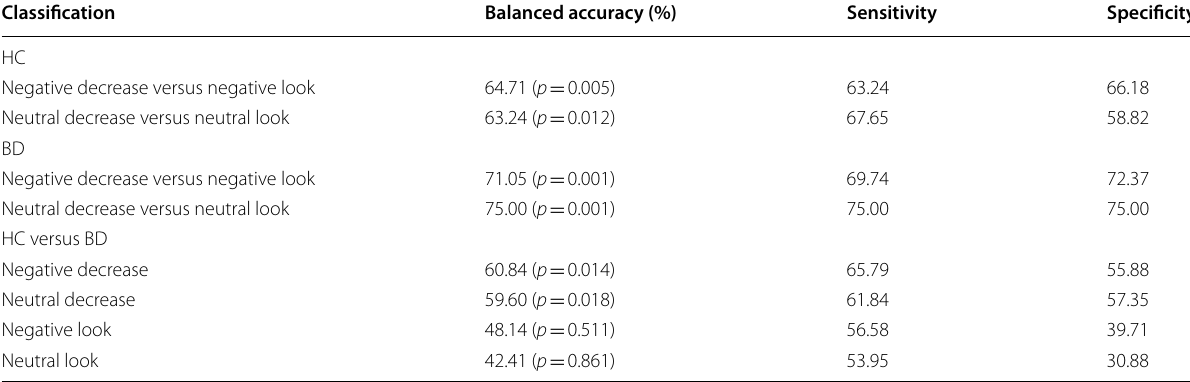
Abbreviations are as follows: HC healthy controls; BD bipolar disorder patients. Sensitivity refers to accurate classification of Decrease trials or BD subjects, whereas = = Specificity indicates the percent of accurately classified for Look trials or HC subjects